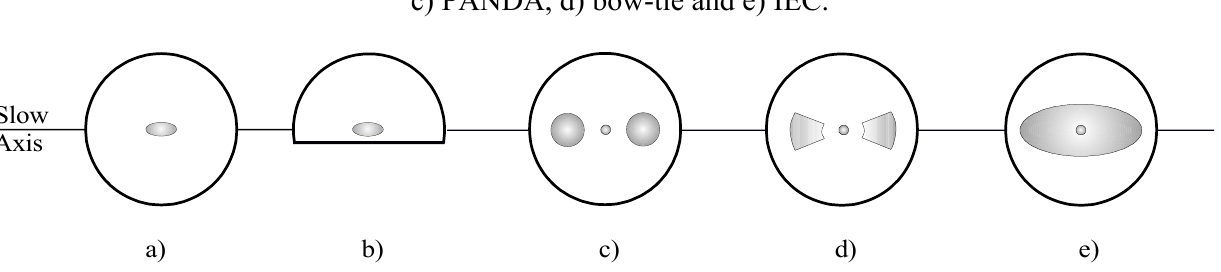
Figure 2. Cross section of conventional Hi-Bi fibers: a) e-core, b) D -type fiber,